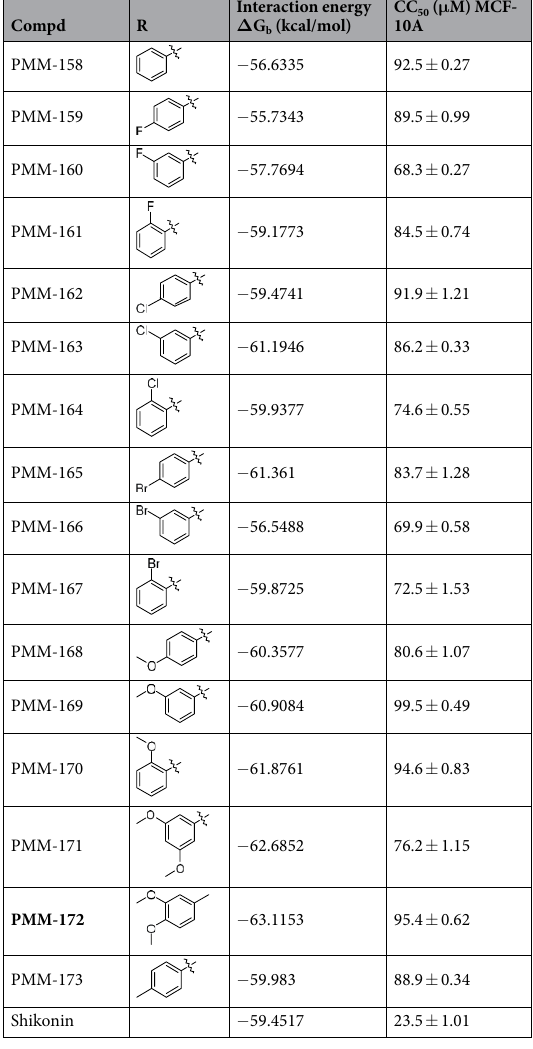
Table 1. The interaction energy and anti-proliferative activity against non-tumorigenic MCF-10A cells of the target